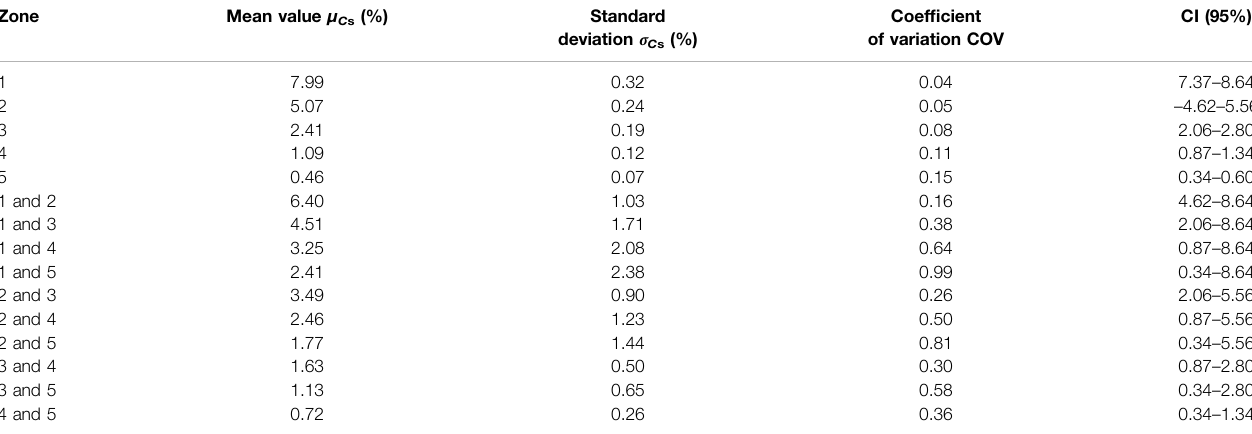
TABLE 2 | Proposed lognormal distributions for C s